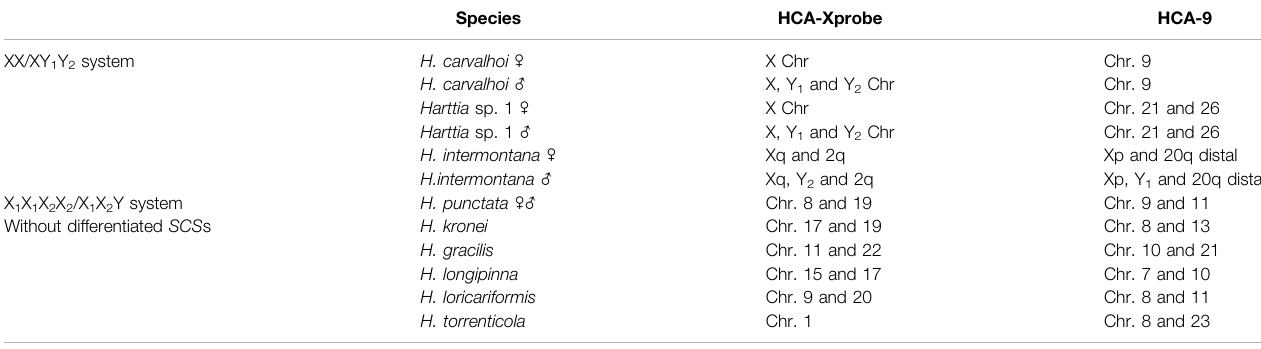
TABLE 2 | Main localization of the WCP probes in Harttia species. Some small signals were not considered. SCSs means sex chromosome